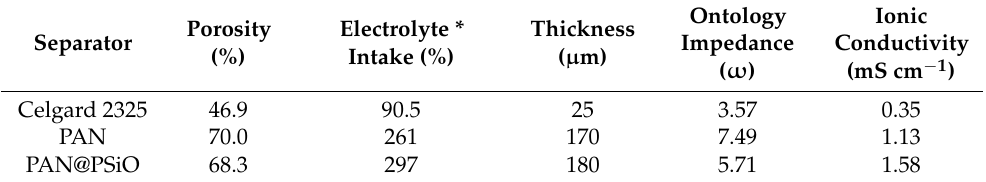
Table 1. The porosity, electrolyte intake, thickness, ontology impedance, and ionic conductivity at room temperature of the three separators. Porosity Electrolyte * Separator (%) Intake (%)